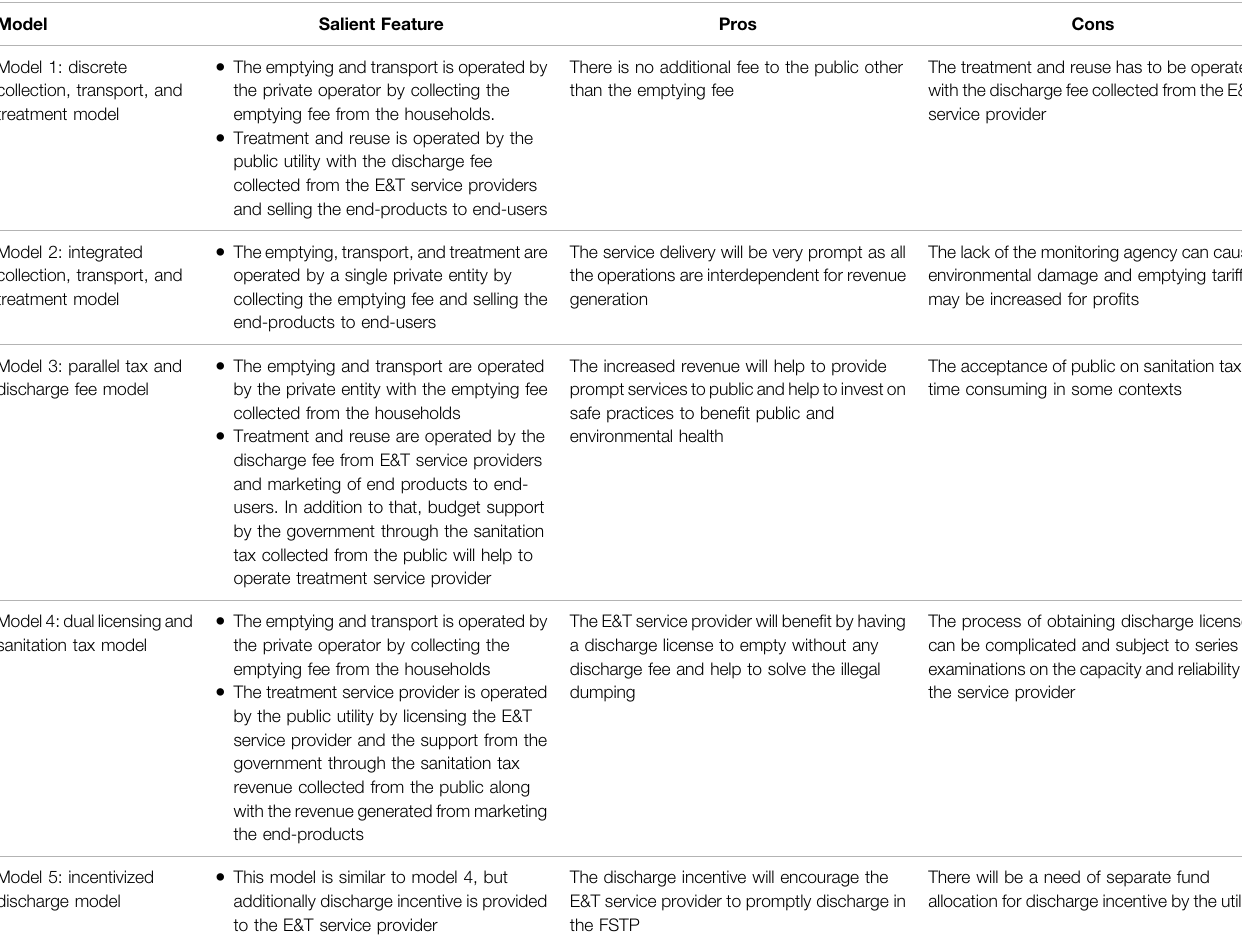
TABLE 1 | Summary of fi nancial fl ow